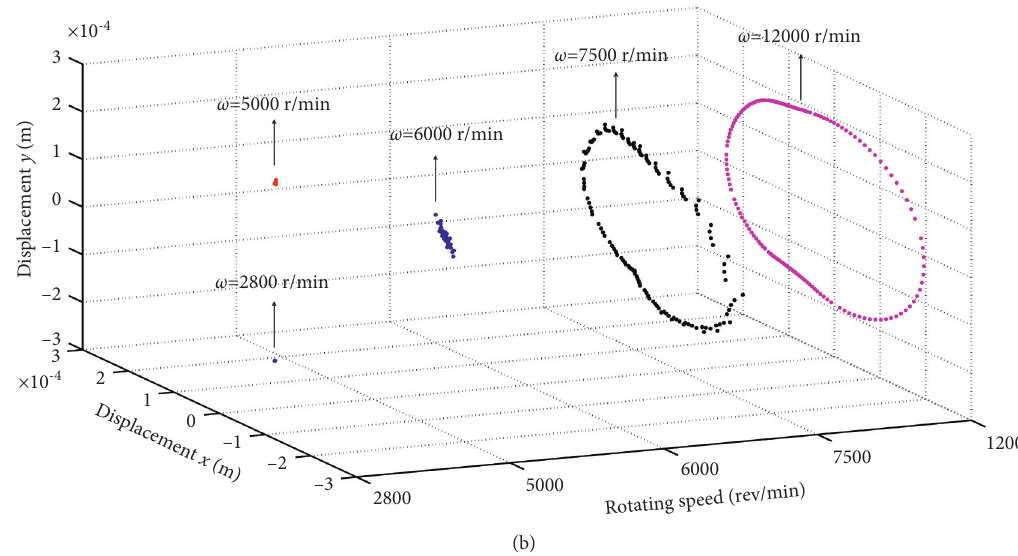
Figure 4: Rotor orbits and Poincar´e maps of the right journal. (a) Rotor orbits. (b) Poincar´e maps.